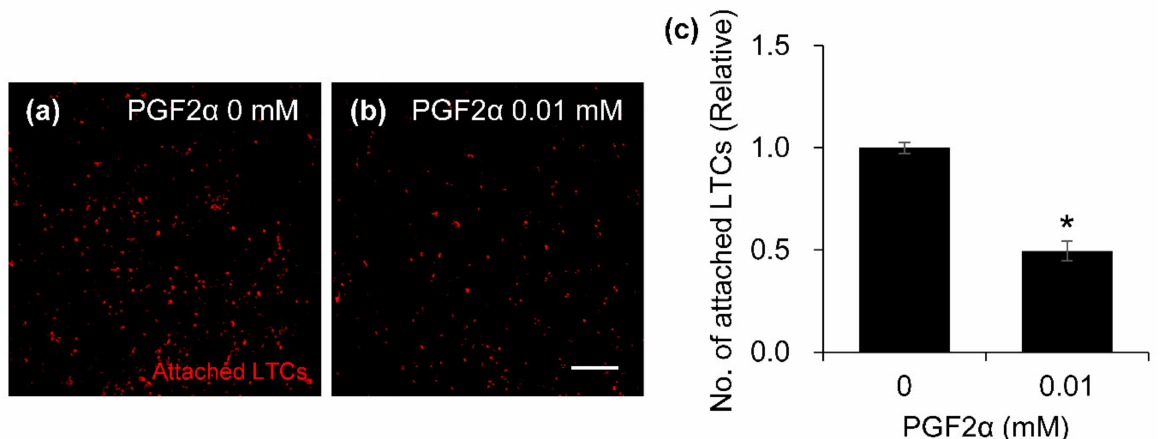
Figure 8. Effect of prostaglandin F2 alpha (PGF2 α ) on cell–cell adhesion ability in bovine luteal theca cells (LTCs). The cell-tracker Red stained LTCs were incubated with 0 mM ( a ) and 0.01 mM ( b ) PGF2 α on the monolayer LTCs. The attached LTCs (( a , b ), red dots) on the monolayer cells were counted using the segmentation tools of ImageJ, and the number of attached cells was normalized to 0 M PGF2 α treatment ( c ). * p < 0.05, n =